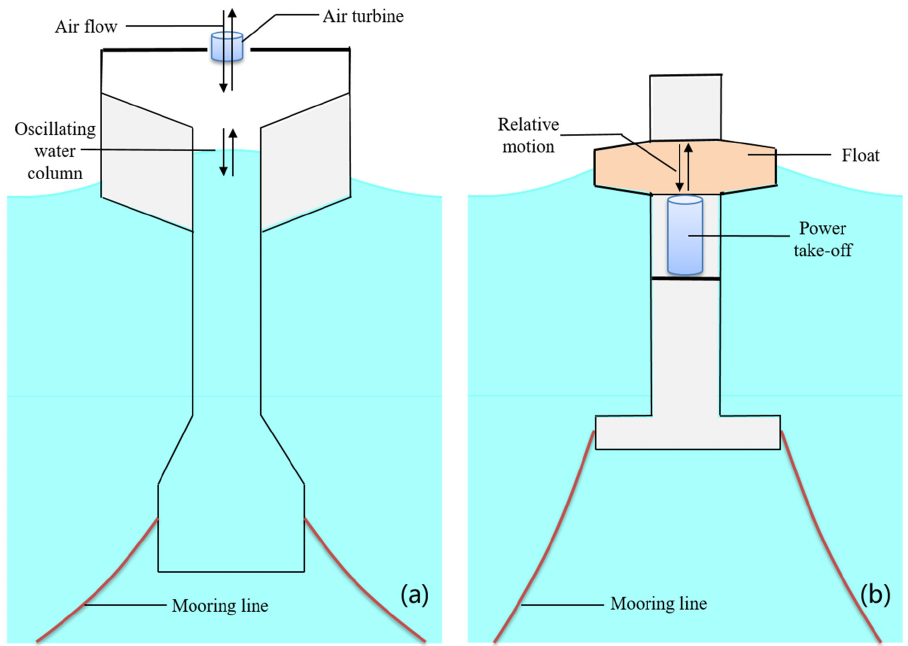
Figure 3. Types of wave energy capture applicable for marine buoys: ( a ) OWC spar type; ( b ) two-body point